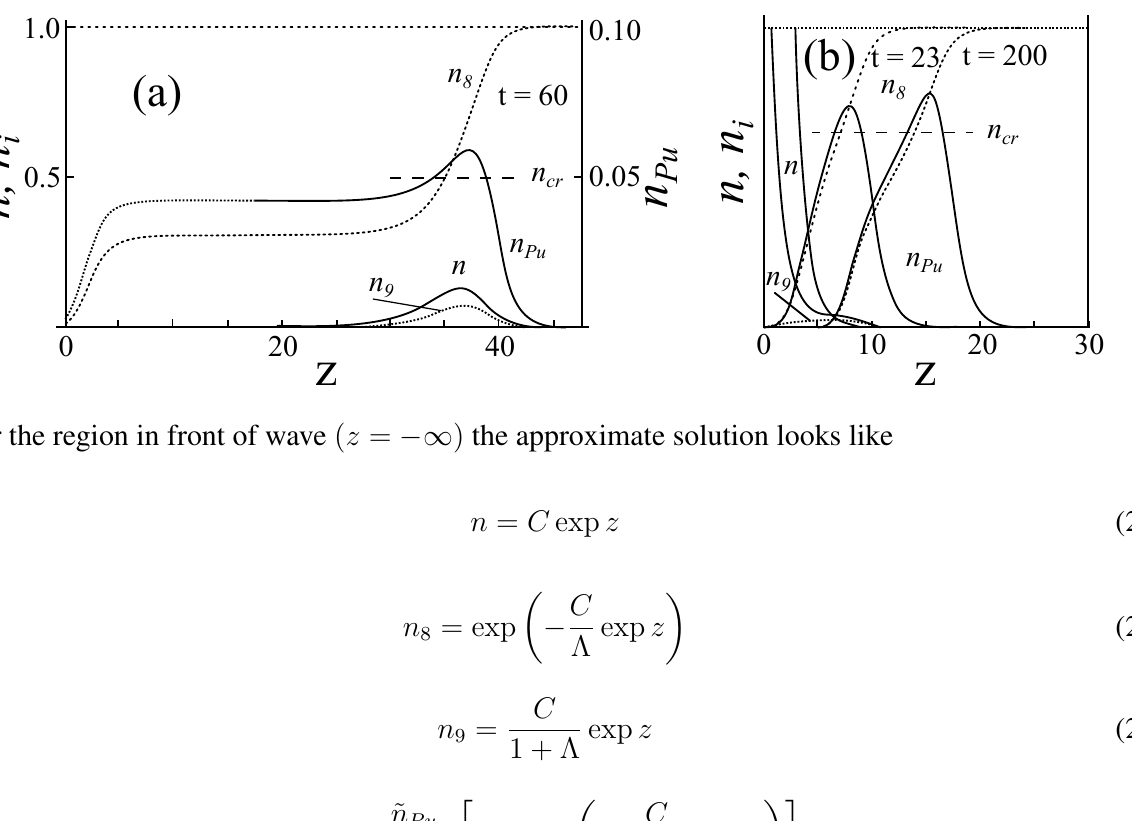
Figure 1. Time dependence of neutron concentration. Propagating wave ( a ) and locked wave; ( b ) a segment of the curve n